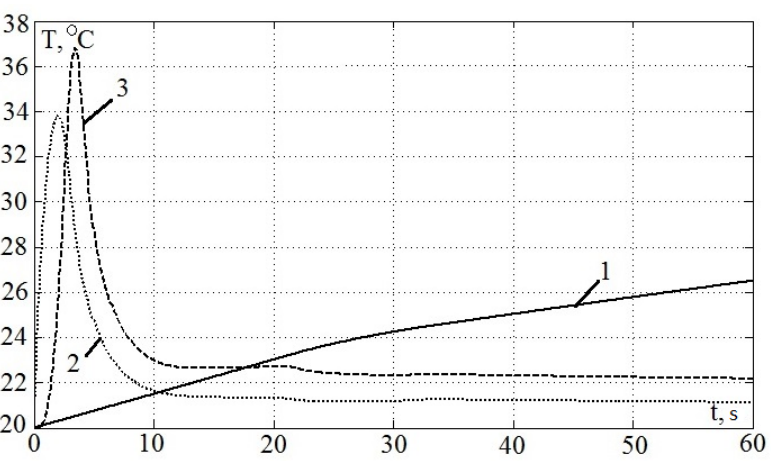
Figure 12. Average temperatures of the traction LIM during soft start. 1—primary winding; 2—secondary conductive plate (area under the primary); 3—secondary conductive plate near the exit end of the primary (area outside the primary).